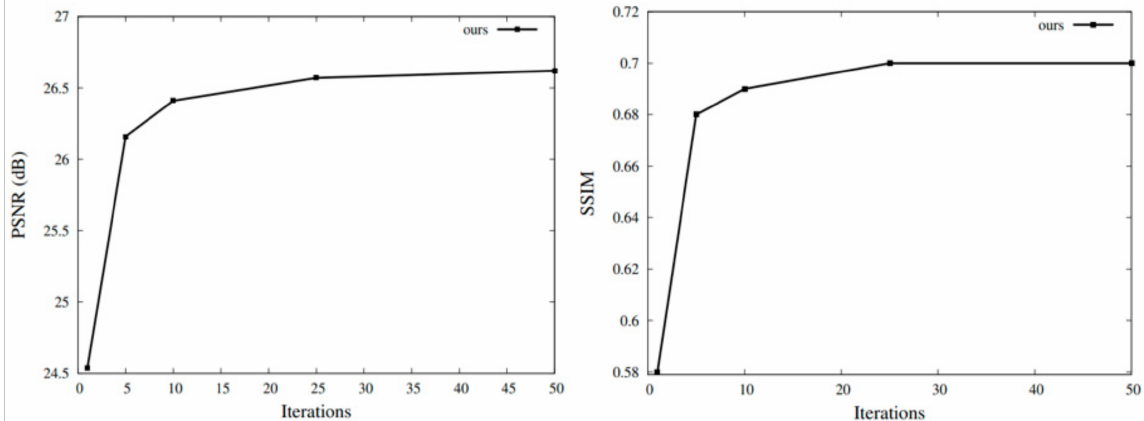
Figure 7. Peak signal-to-noise ratio (PSNR) and structural similarity index measure (SSIM) versus the number of iterations. Both the PSNR and SSIM increased with the number of iterations and gradually